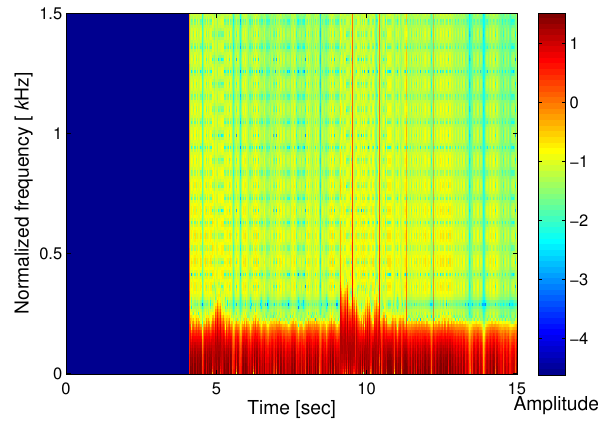
Figure 6. STFT result of the seismic wave.